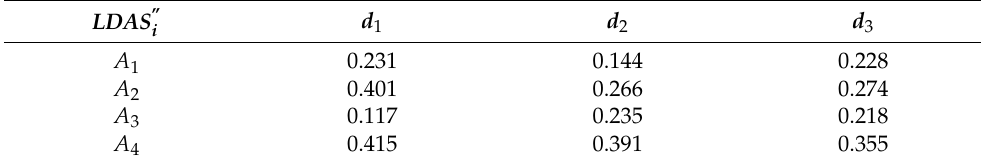
Table 7. The value of LDAR (cid:48)(cid:48)